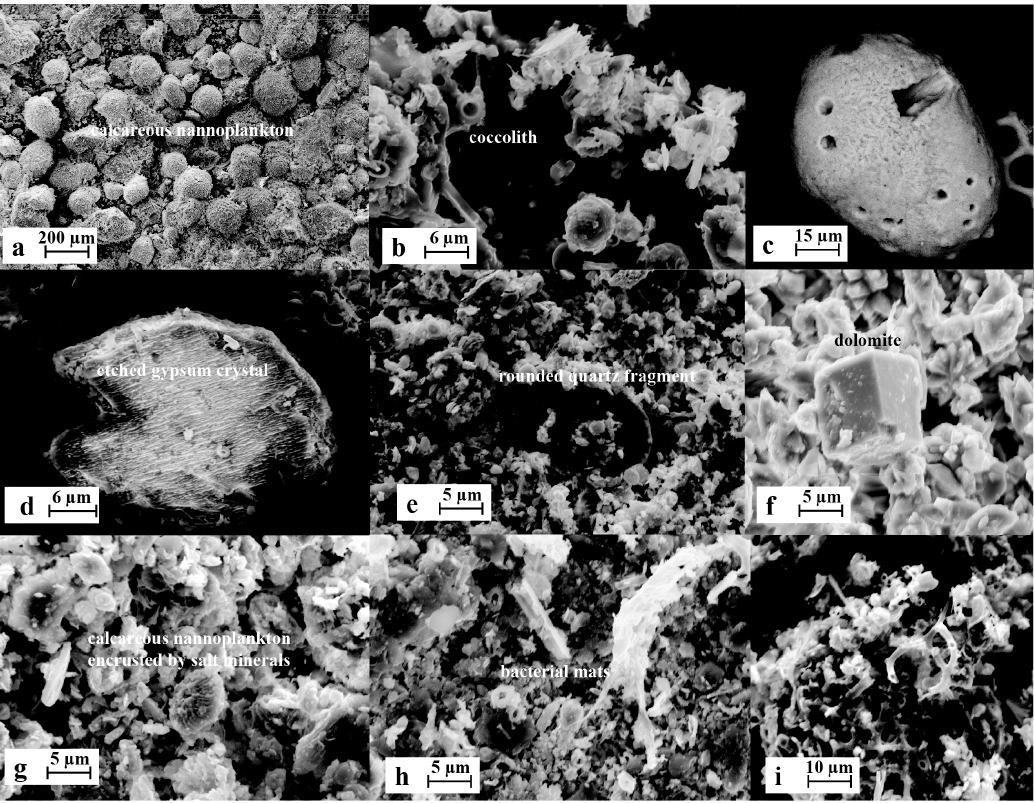
Fig. 2. SEM observations of studied sediments: (a) detrital carbonate fraction formed by calcareous nannoplankton; (b) possible effects of microbial activity in sediments; (c) Mg-free detrital calcite, probably from the “Calcare di Base” formation of Messinian age (see typical cubic crystal ghost of halite); (d) etched gypsum crystal showing dissolution figures; (e) rounder quartz grain, probably of aeolic origin, enclosed in fine-grained sediment; (f) fine-rhombohedral dolomite in fine-grained sediment; (f) authigenic salt minerals encrusting detrital nannoplankton; (h) possible “organic” textures in sediment; (i) possible “organic” textures in sediment and associated bioclastic